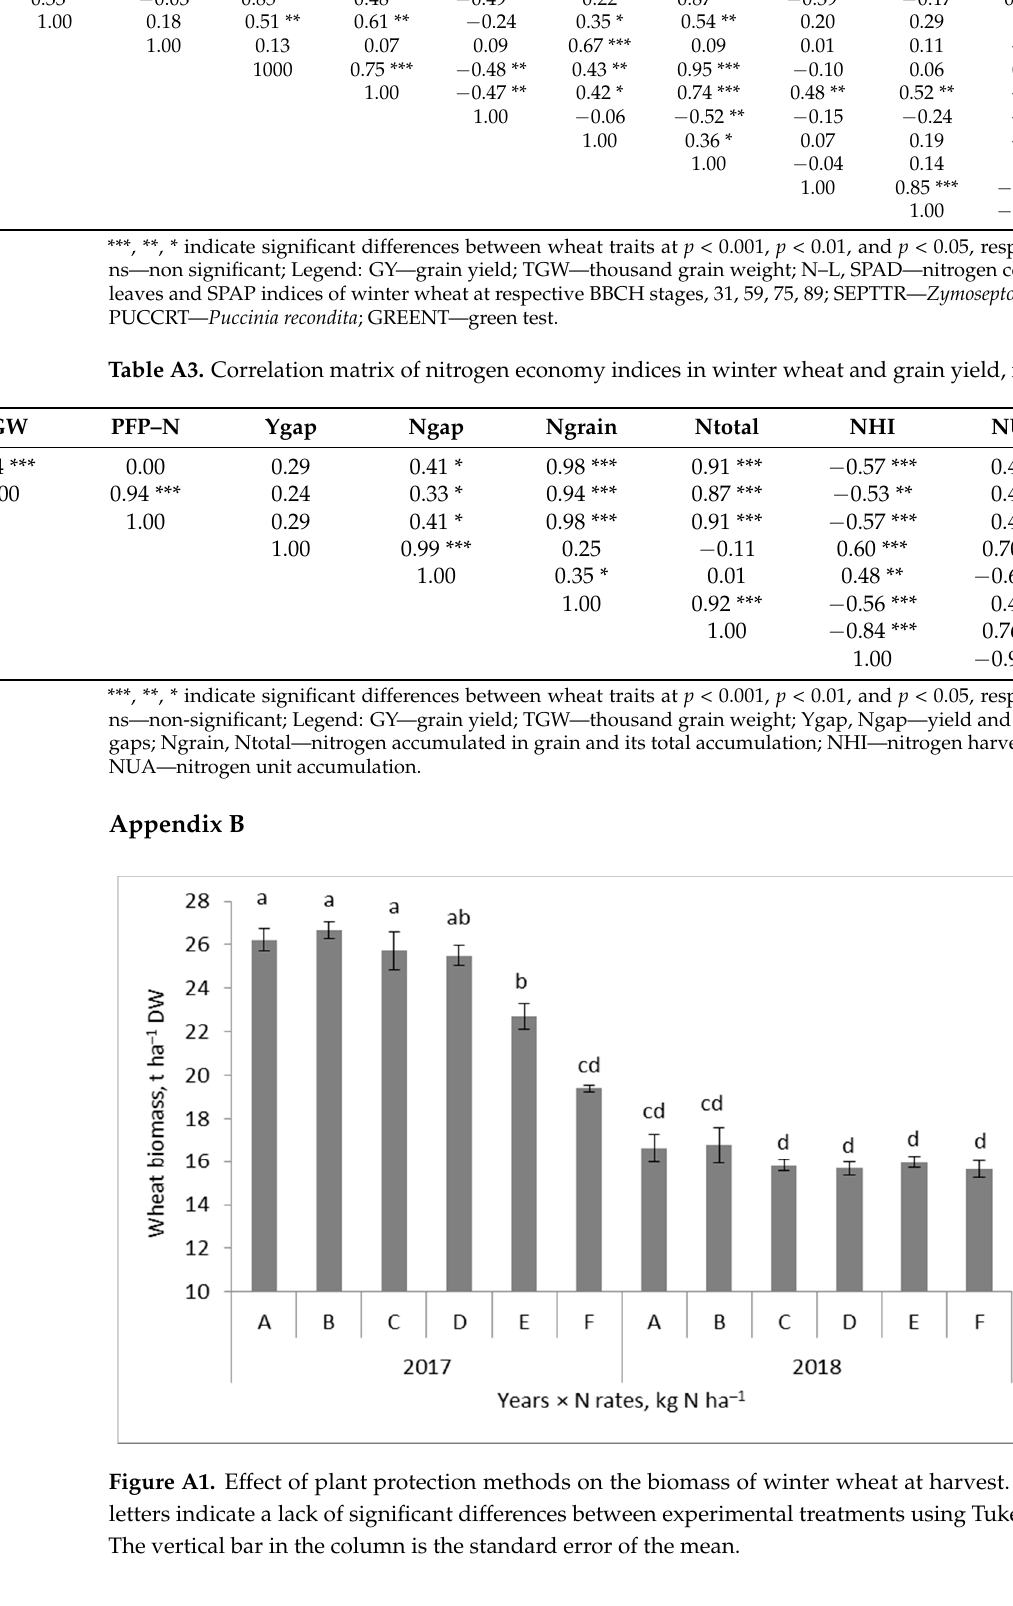
Figure A2. Effect of plant protection methods on the nitrogen content in leaves of winter wheat at BBCH 75. Similar letters indicate a lack of significant differences between experimental treatments using Tukey’s test. The vertical bar in the column is the standard error of the mean.